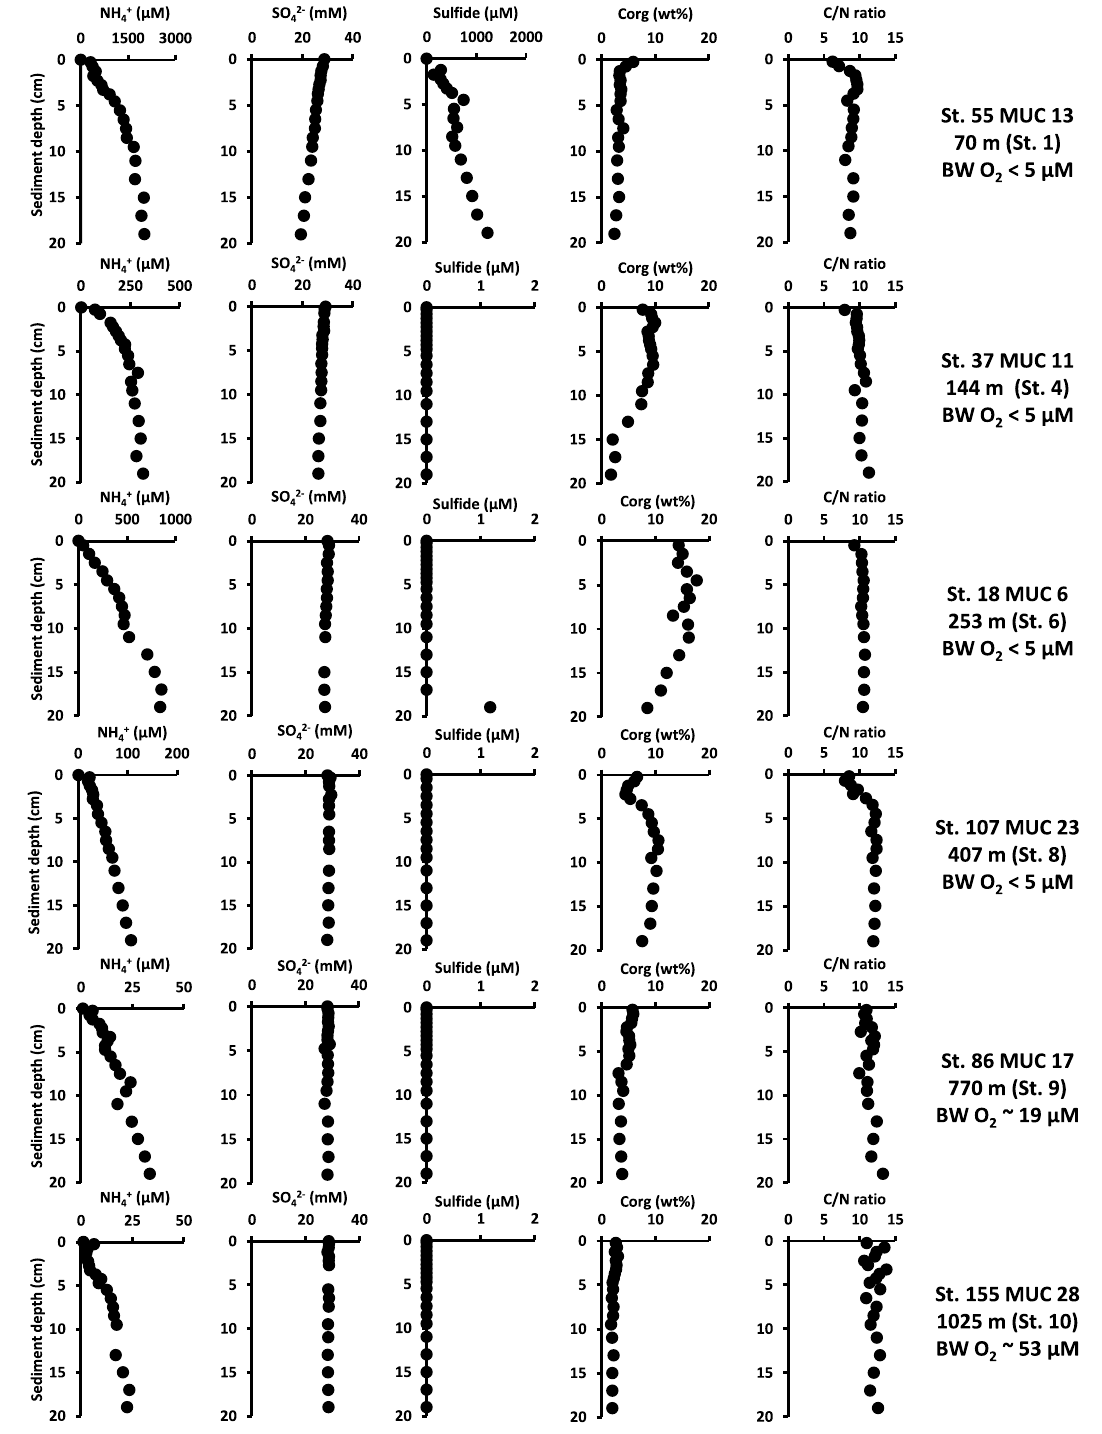
Figure 2. Biogeochemical porewater profiles in MUC cores from sampling stations along the 12 ◦ S depth transect. Graphs show NH + SO 2 − (mM), sulfide (µM), organic carbon content (C org , wt%) and the C / N ratio (molar). Water depths and bottom water O 2 concentrations 4 (BW O 2 , µM) are detailed on the